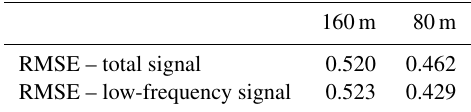
Table 1. Wind RMSE depending on the forcing